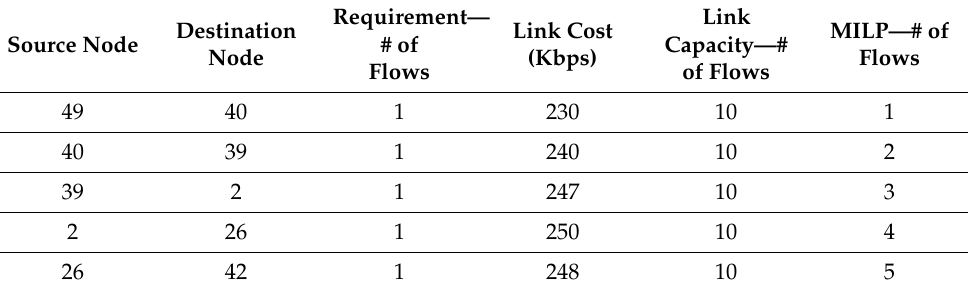
Figure 7. Routing with the capacity of the links—Table 3. Table 3. ZigBee simulation (250 Kbps)—flows were generated by using